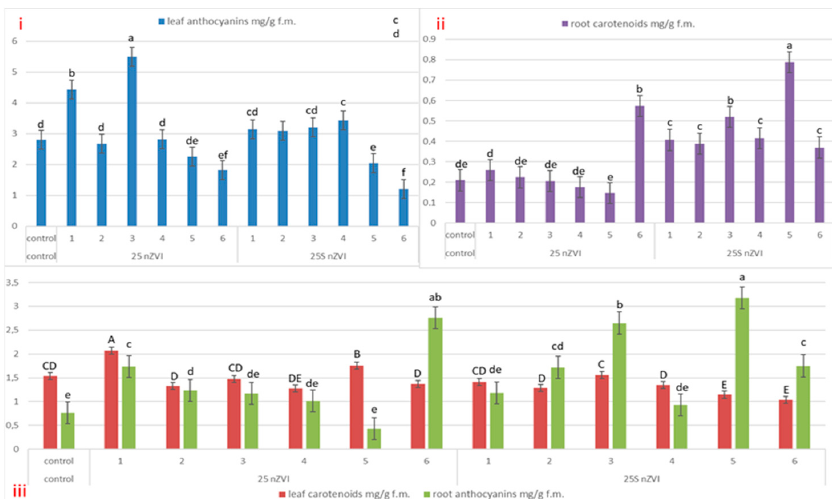
Figure 6. The content of anthocyanins in shoots ( i ) and roots ( iii ) and carotenoids in shoots ( iii ) and roots ( ii ) of plants grown in soil contaminated with the 25 and 25S nZVI. The numbers 1–6 correspond to the following concentrations: 0.5; 1; 5; 10; 50 and 100 g nZVI/kg soil. Vertical bars represents the mean values (n = 5) ± standard deviations. Different letters indicate significant difference at p < 0.05 by LSD test.